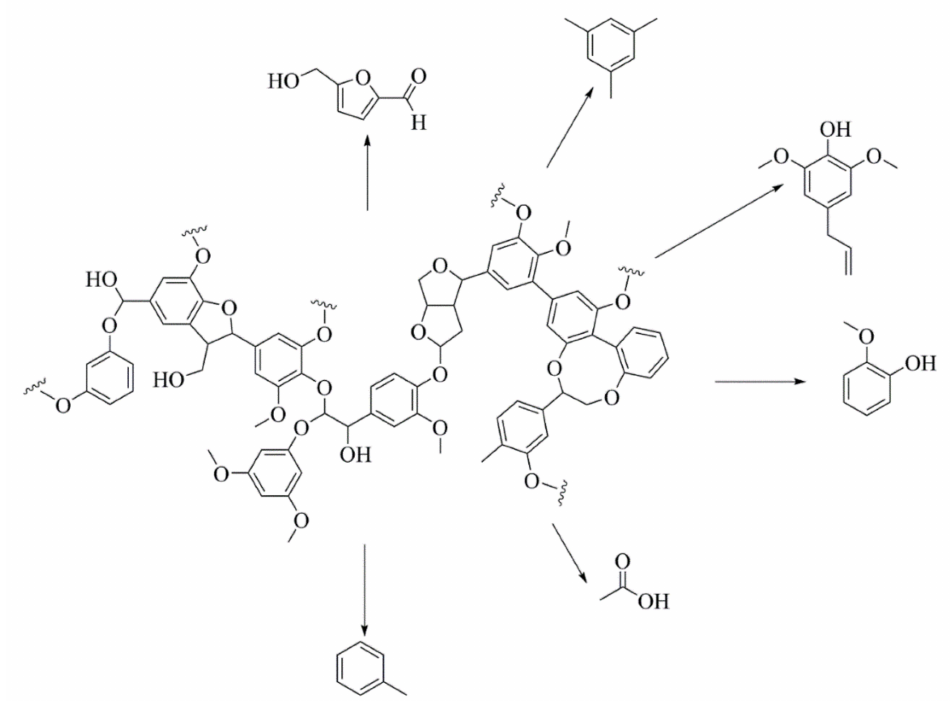
Figure 3. Schematic representation of lignin degradation under pyrolytic conditions. Main products are herein